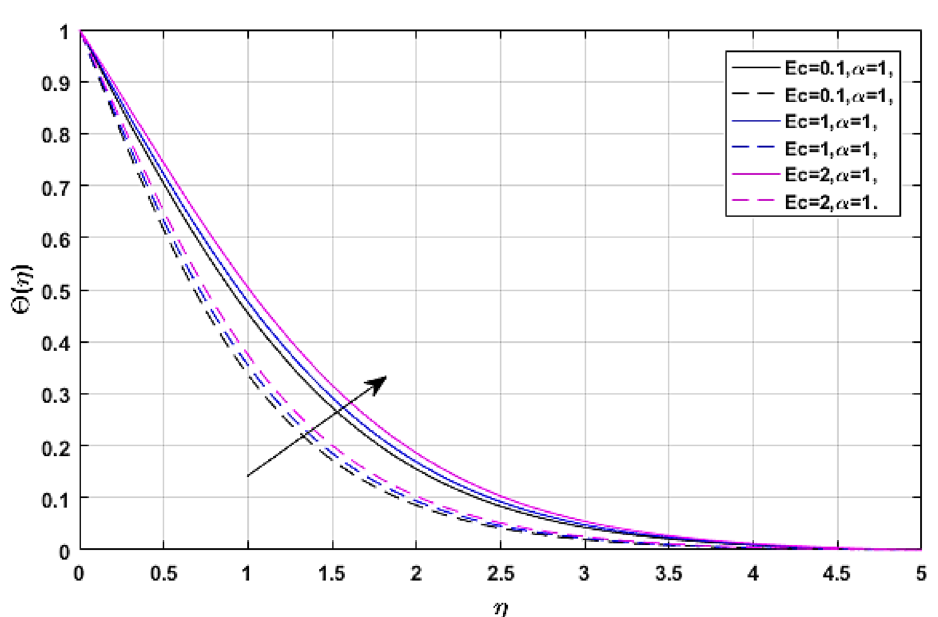
Figure 15. Ec versus temperature field when (cid:31) = M = E = 0.1, φ 1 = φ 2 = 0.02, Pr =